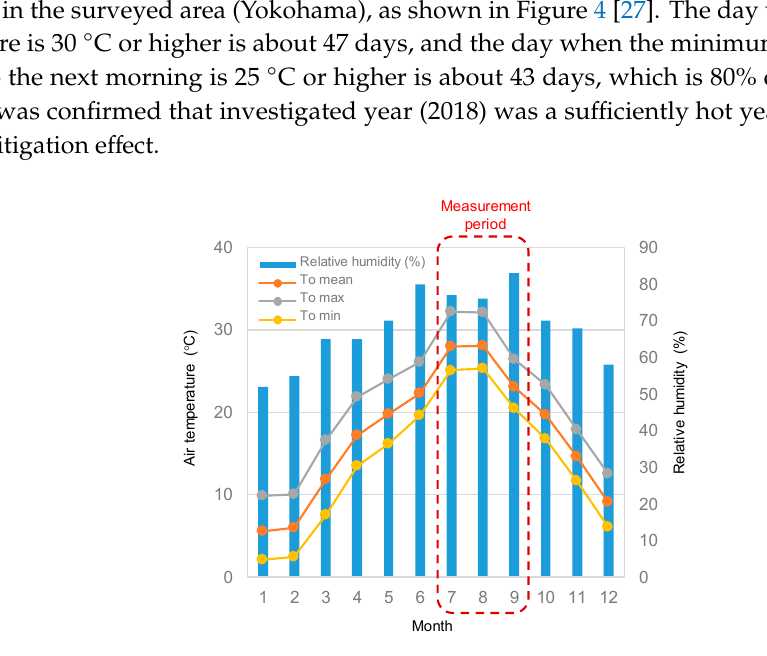
Figure 2. Outdoor air temperature ( T o ) and outdoor relative humidity in the investigated area.